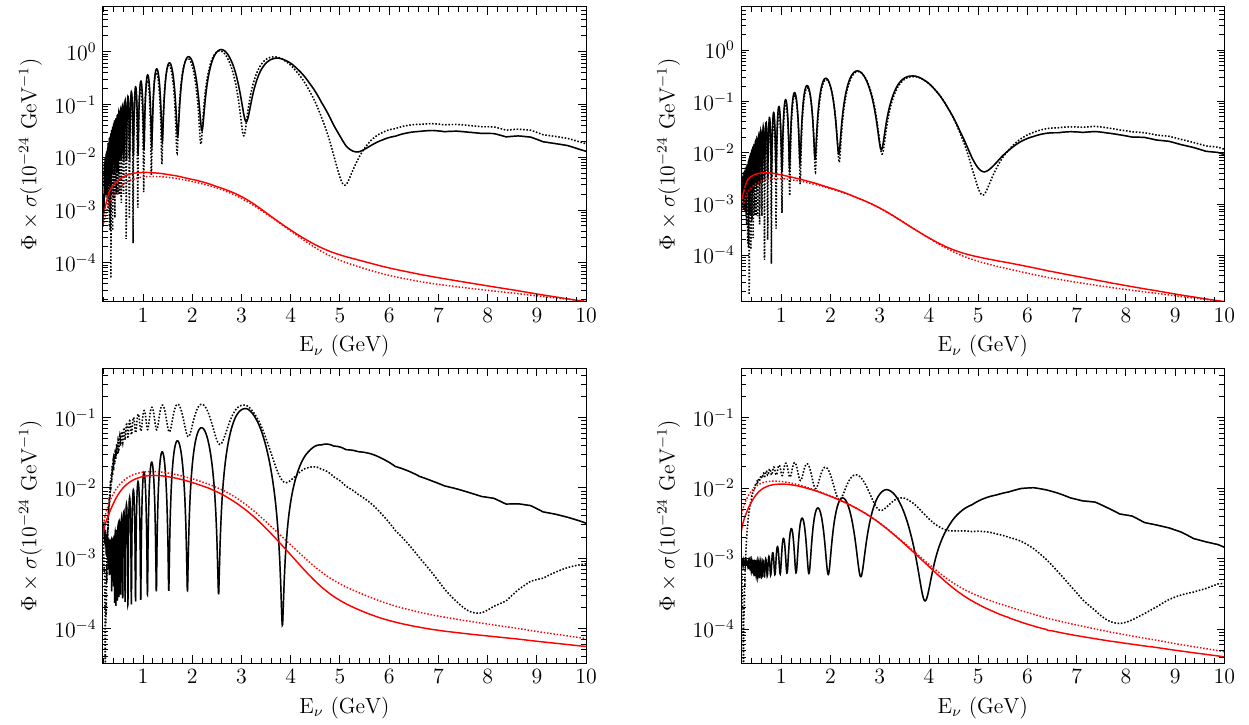
Fig. 2 ((cid:9) × σ) at ANDES, for ν μ disappearance (top) and ν e appearance (bottom) channels. The left (right) column shows results considering the FHC (RHC) flux. Curves as in Fig.